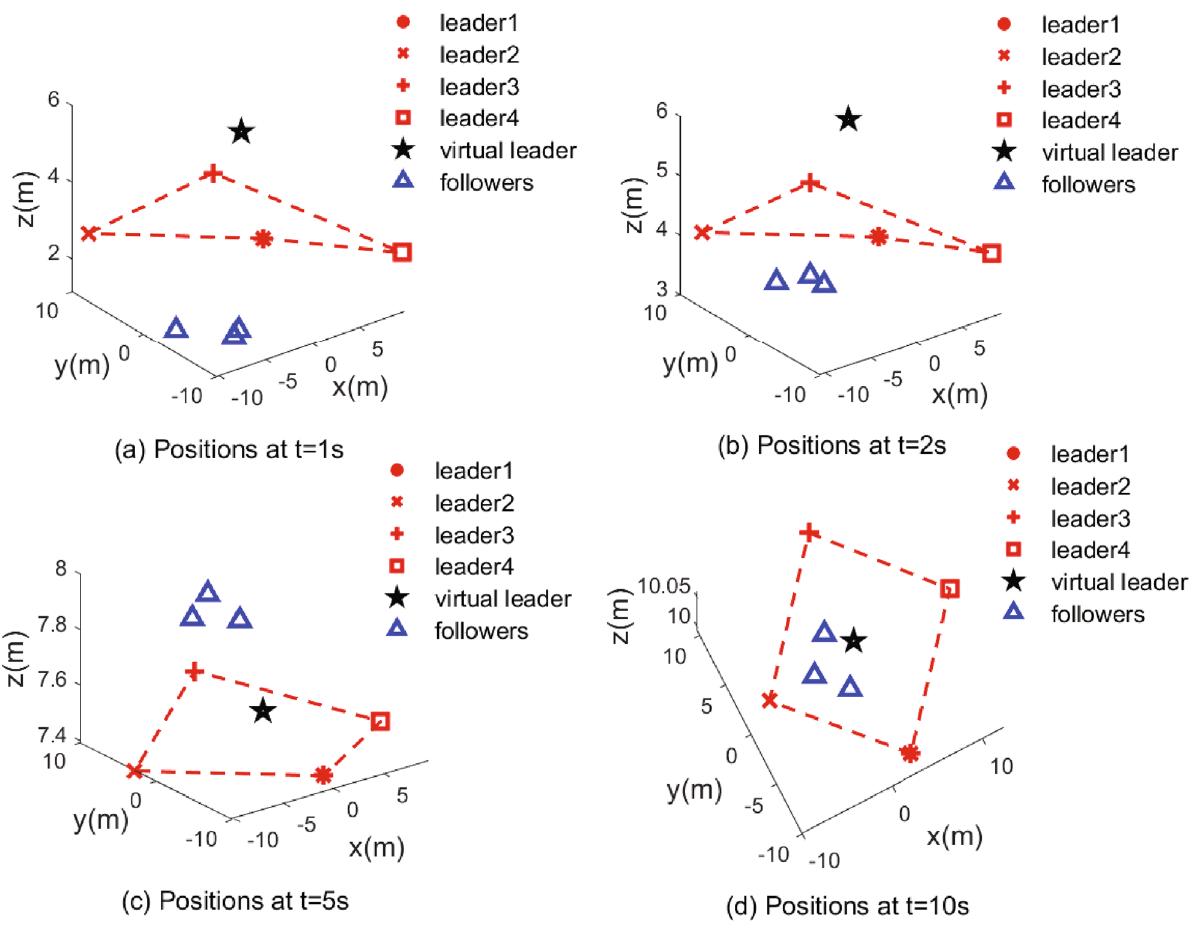
Figure 5. Position snapshots at t = 1 s, 2 s, 5 s, 10 s for the UAVs.